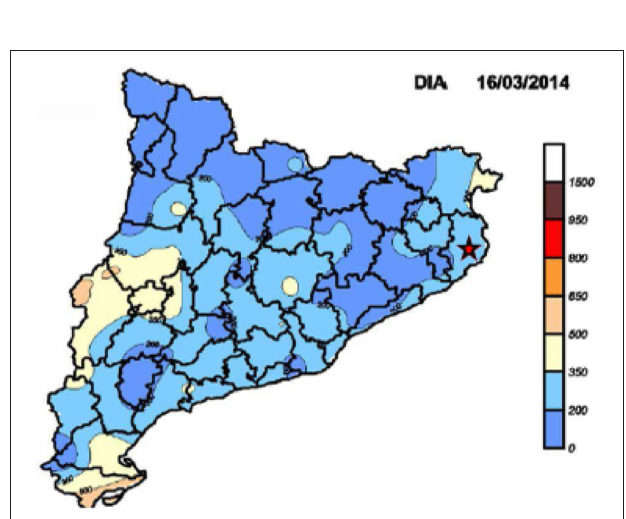
FIGURE 3 | Drought index values on 16/03/14 over Catalunya. The star symbol marks Vall-llobrega location. Source: GRAF